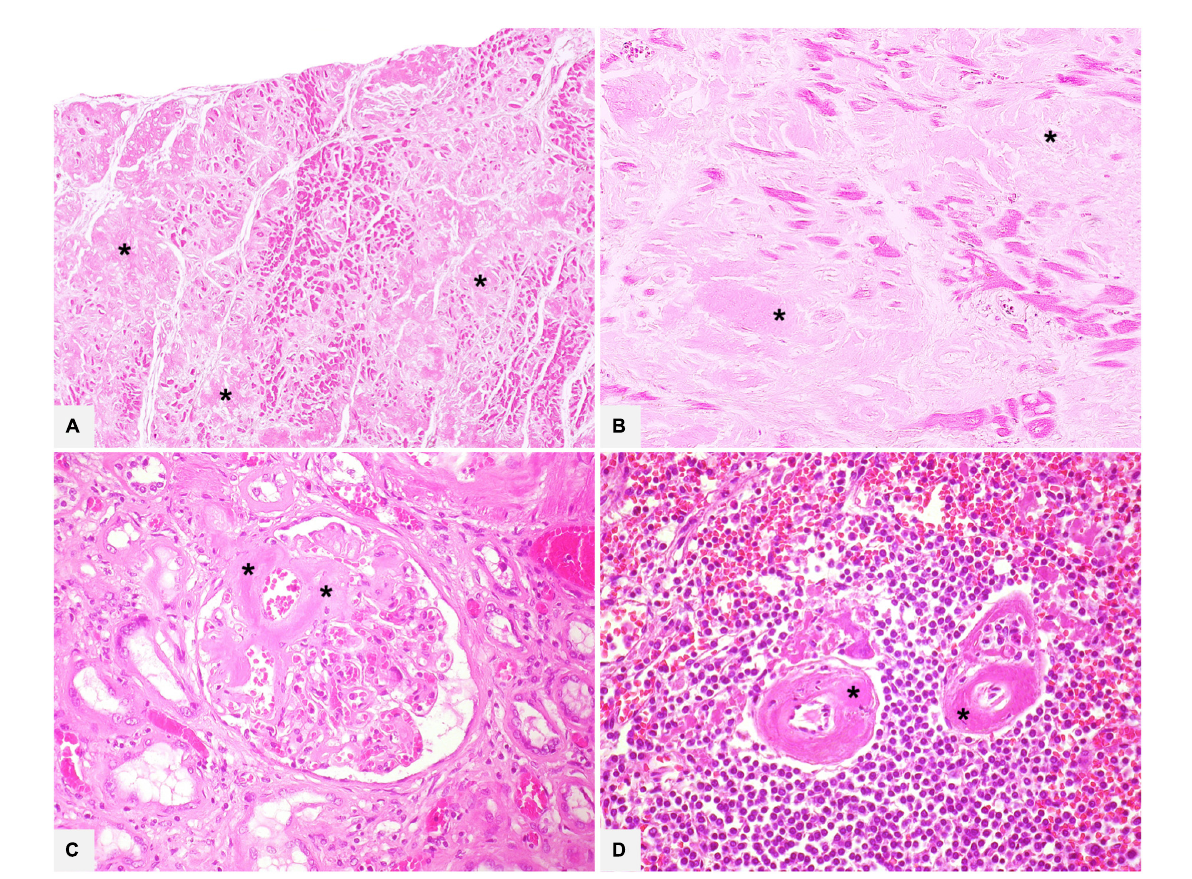
FIGURE1 Various organ specimens ( A: heart left atrium; B: heart left ventricle; C: kidney; D: spleen) in cases of systemic amyloidosis showing extracellular eosinophilic, amorphous, and homogeneous amyloid deposits (asterisks). Hematoxylin-Eosin: (A) 50 × ; (B) 200 × ; (C,D) 400 ×